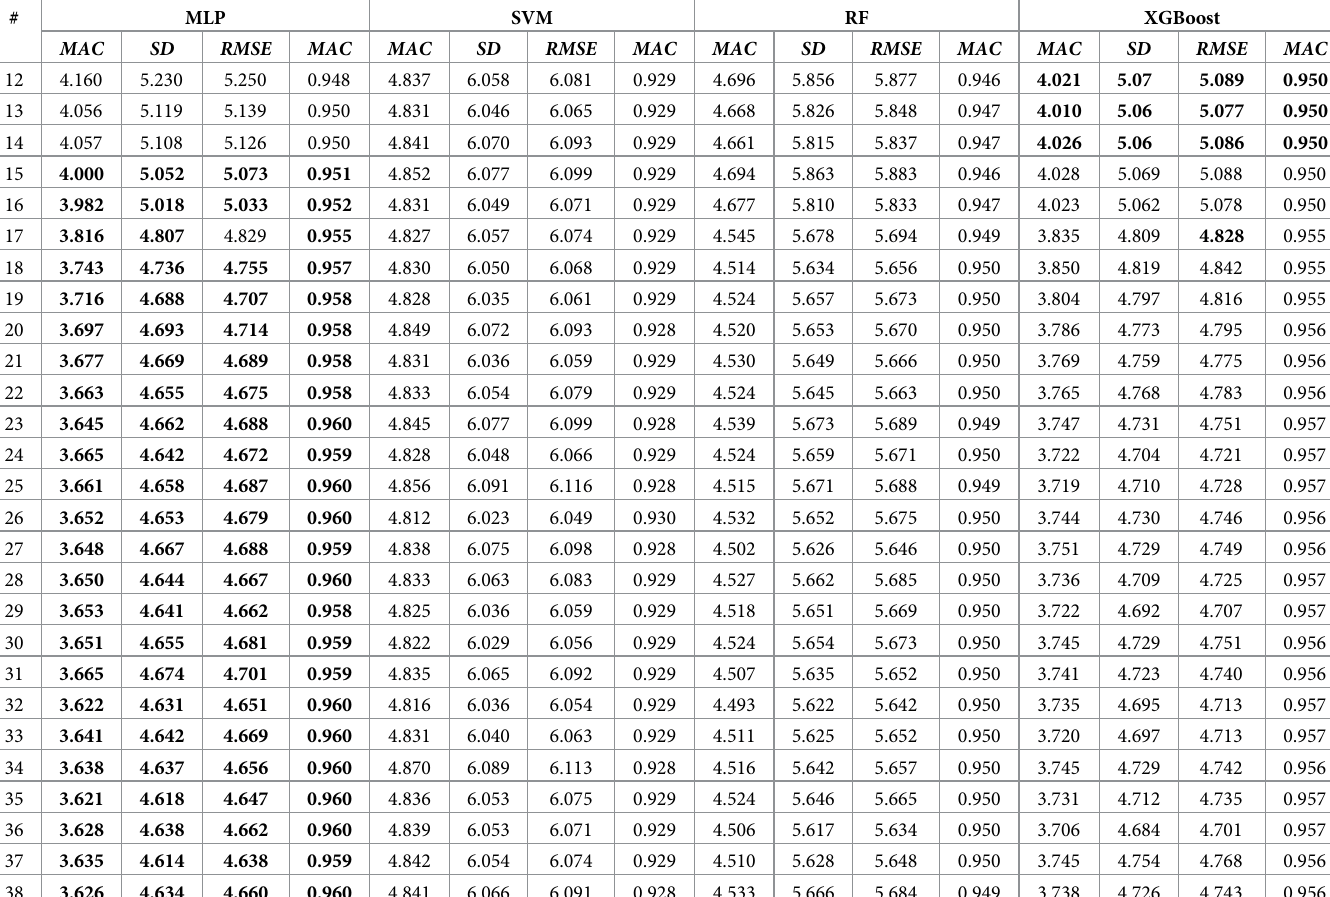
Table 12. Experimental results for the MLP, SVM, RF, and XGBoost, based on the NHANES dataset, with PCA feature extraction (best results are highlighted in bold; # means the number of